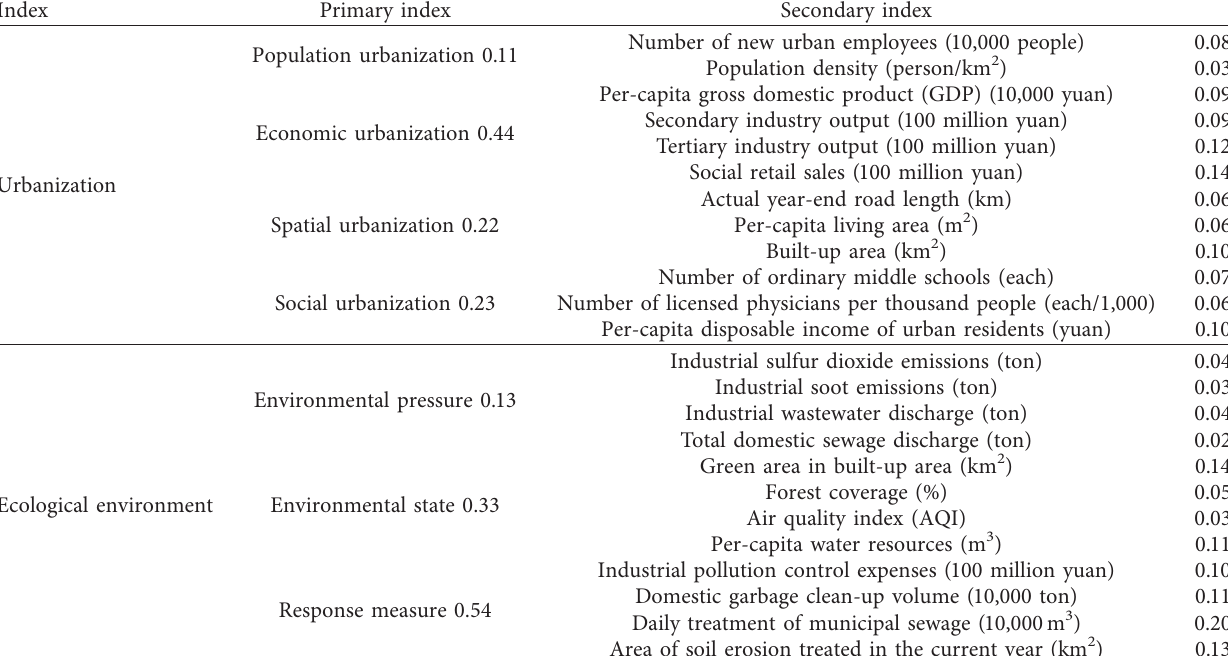
Table 2: Index weights of urbanization and ecological environment.